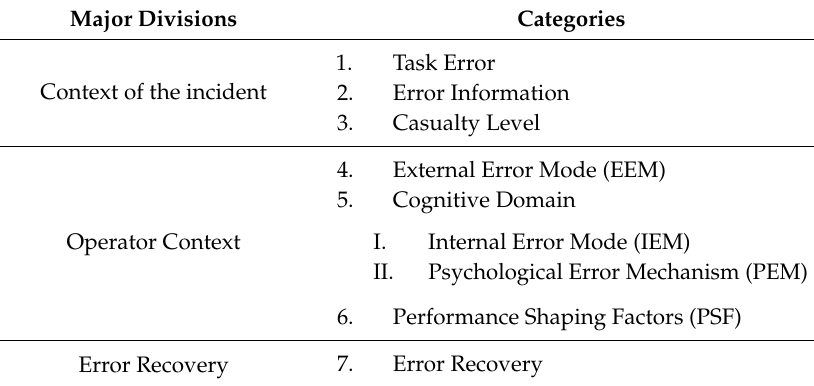
Table 1. Levels and subdivisions of TRACEr taxonomy